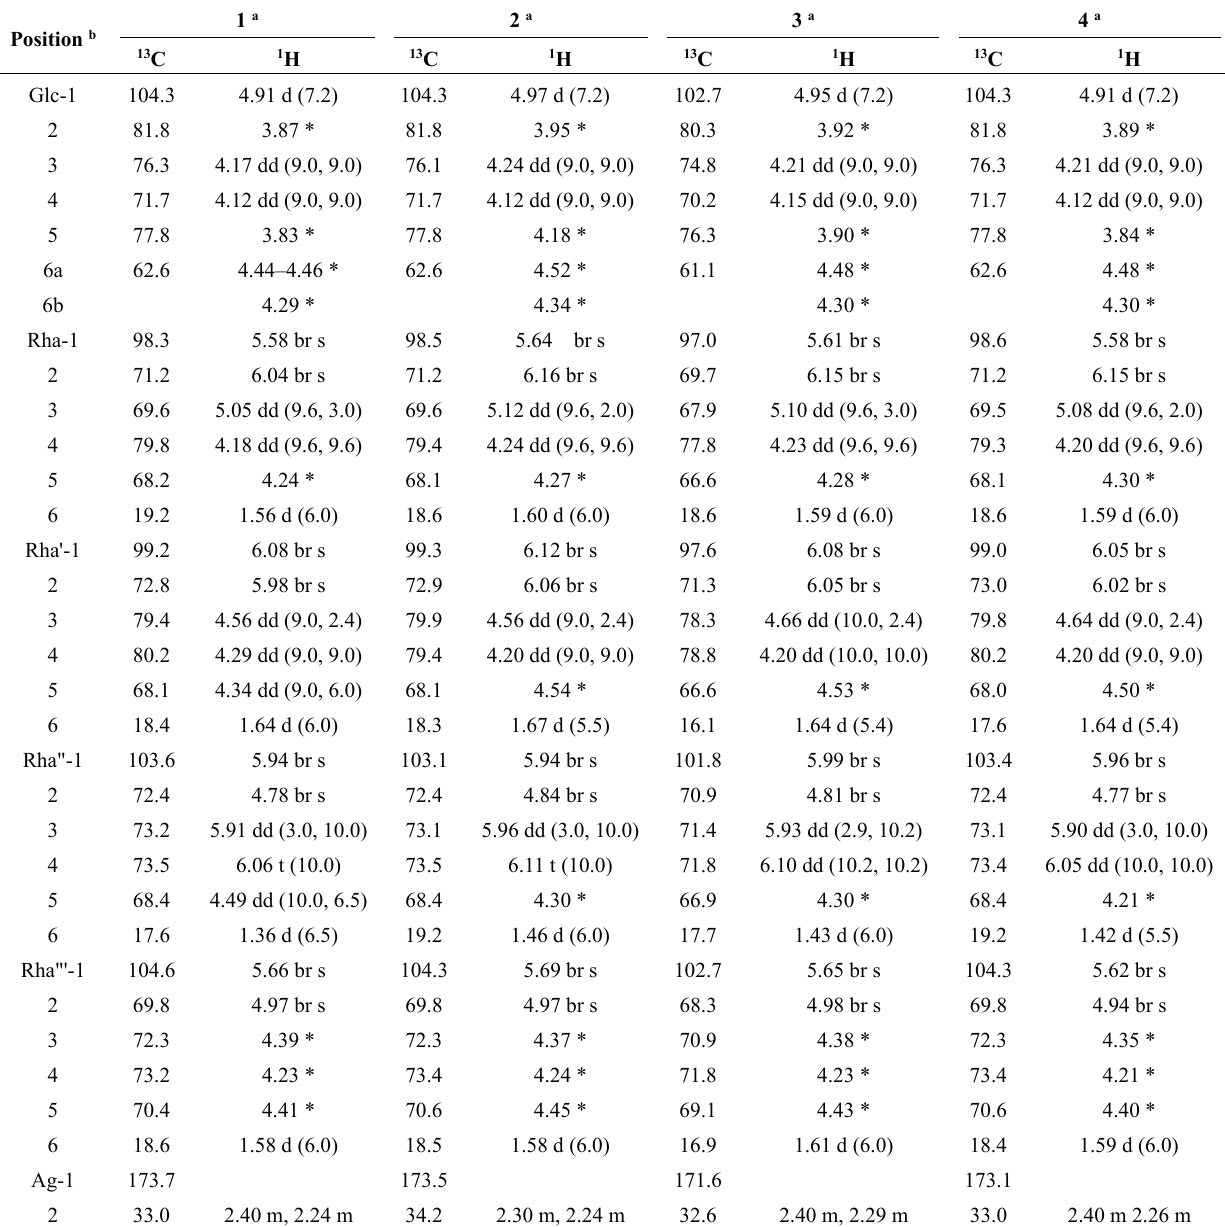
Figure 1. The structures of compounds 1 – 6 . Table 1. NMR Data for Compounds 1 – 4 in pyridine- d 5